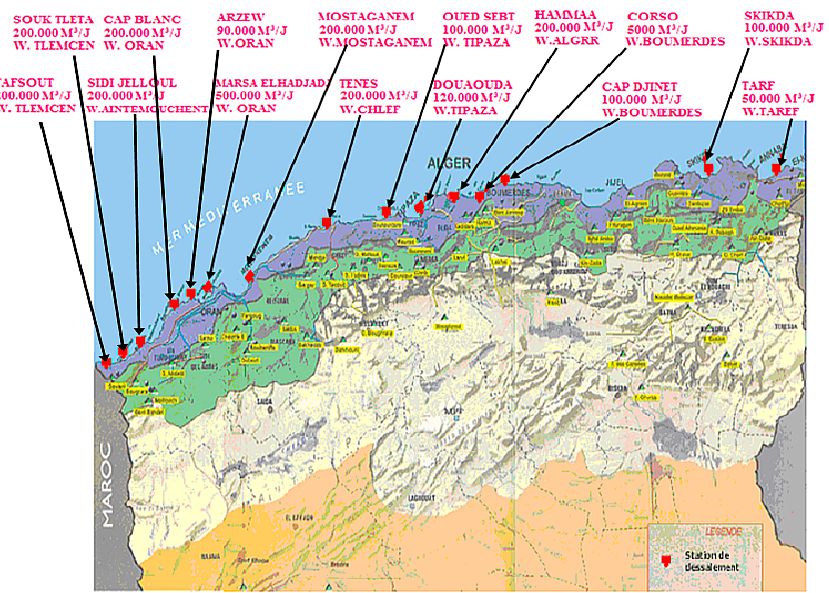
Figure 9. Geographical locations of 13 seawater desalination plants in Algeria. Table 7. The physicochemical parameters of seawater for different places.